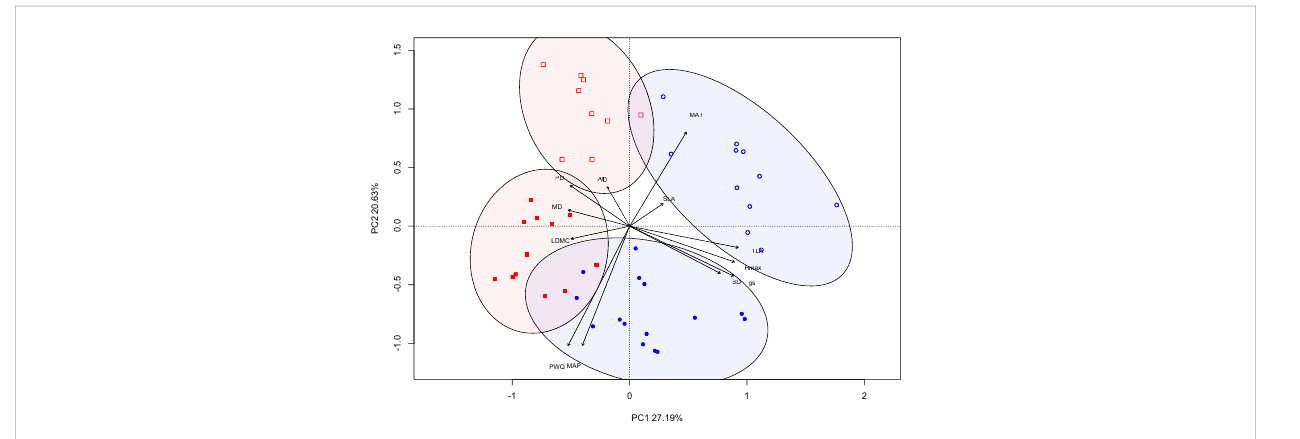
FIGURE 2 PCA analysis of plant traits for wet and dry origin populations grown under different water treatments. Open and closed shape signi fi es dry and wet-climate-origin, while blue-circle and red-square signi fi es water-limited and well-watered